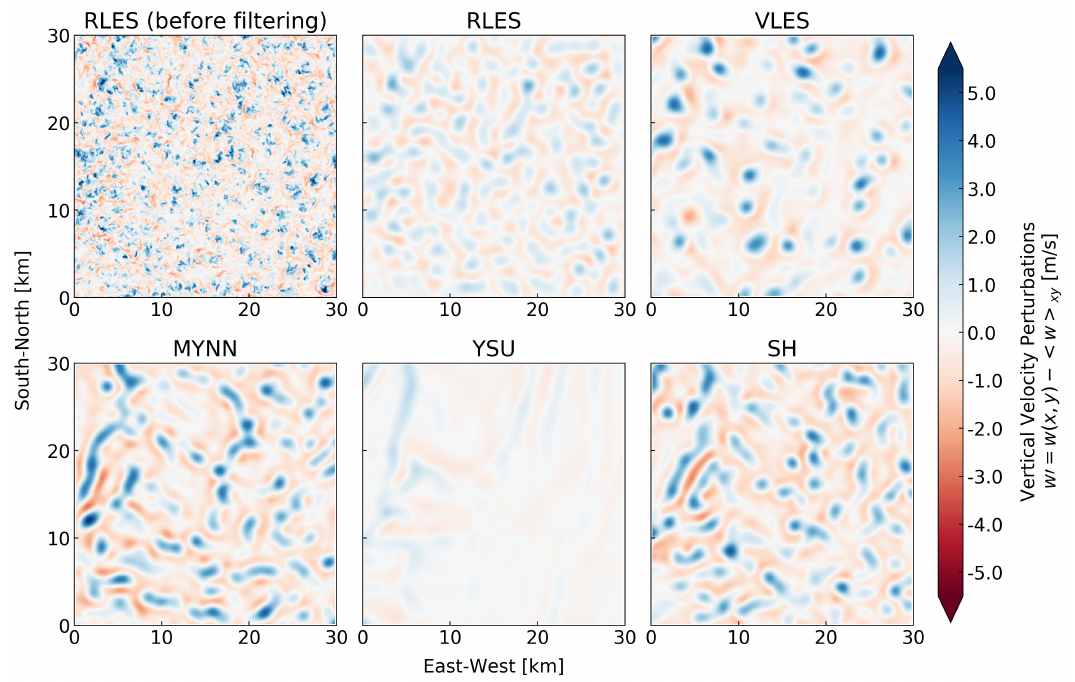
Figure 14. Contours of vertical velocity perturbations at z / z i = 0.5 for all simulation strategies on 21 March, 2100 UTC (1500 LT). This time represents a peak in − z i / L , as shown in Figure 4d. For completeness, RLES is shown before and after spatial